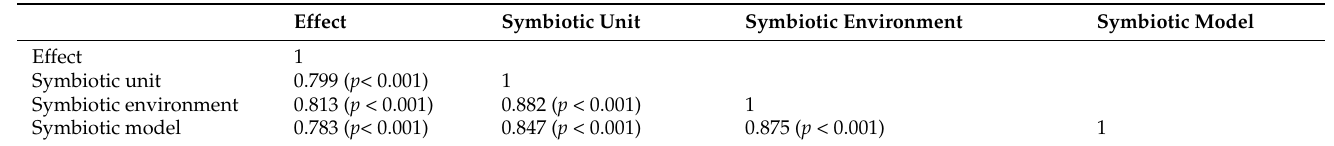
Table 7. Pearson correlation coefficient